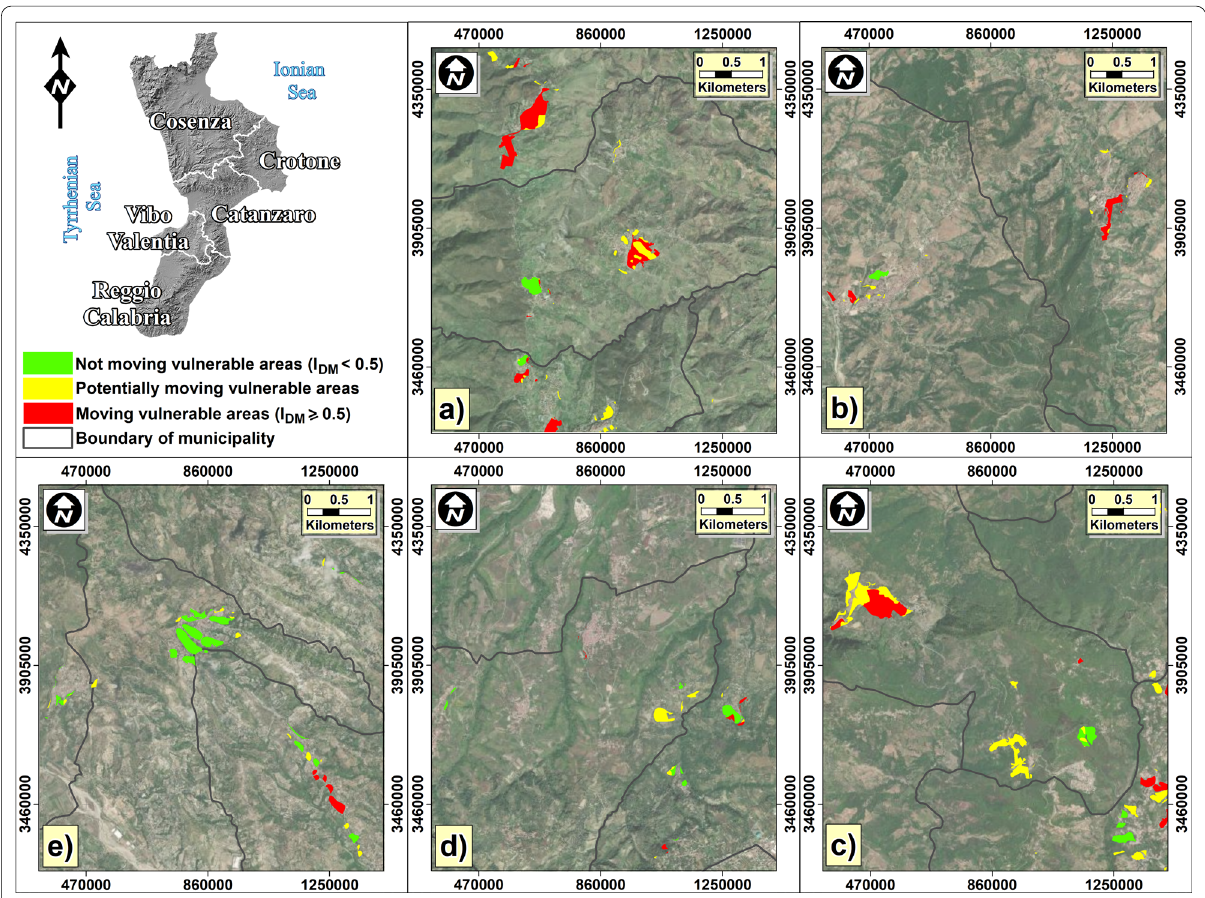
Fig. 9 Distribution of VAs distinguished in “ not moving ”, “ potentially moving ” and “ moving ” according to the Index of DInSAR-based movement (I DM ) values. The shown VAs correspond to the ones identified in Fig. 8 (white-boxes) for the Provinces of: a Cosenza, b Crotone, c Catanzaro, d Vibo Valentia and e Reggio Calabria